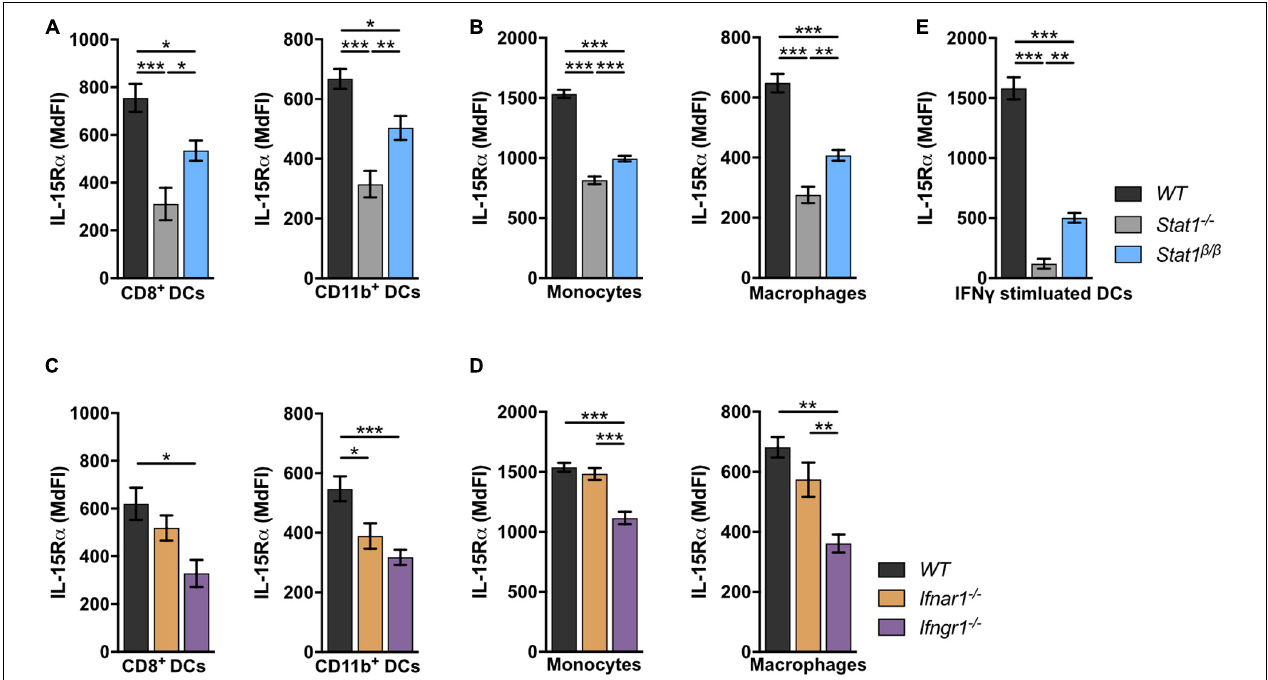
FIGURE 5 | Stat1 − / − , Stat1 β / β , Ifnar1 − / − , and Ifngr1 − / − mice have reduced IL-15R α surface levels on various splenocytes. (A–D) Surface levels of IL-15R α were determined on splenic DCs subsets (A,C) , monocytes and macrophages (B,D) from WT , Stat1 − / − , and Stat1 β / β mice (A,B) and from WT , Ifnar1 − / − , and Ifngr1 − / − mice (C,D) using flow cytometry. Mean MdFIs ± SEM ( n = 7–11) from three experiments are shown (A–D) . (E) Magnetic beads-isolated, splenic DCs from WT , Stat1 − / − , and Stat1 β / β mice were treated with or without IFN γ (100 U/ml) after 16 h and IL-15R α surface levels were determined by flow cytometry. Mean MdFIs (IFN γ treated minus untreated control) ± SEM ( n = 4) from two experiments are shown. * p < 0.05; ** p < 0.01; *** p <